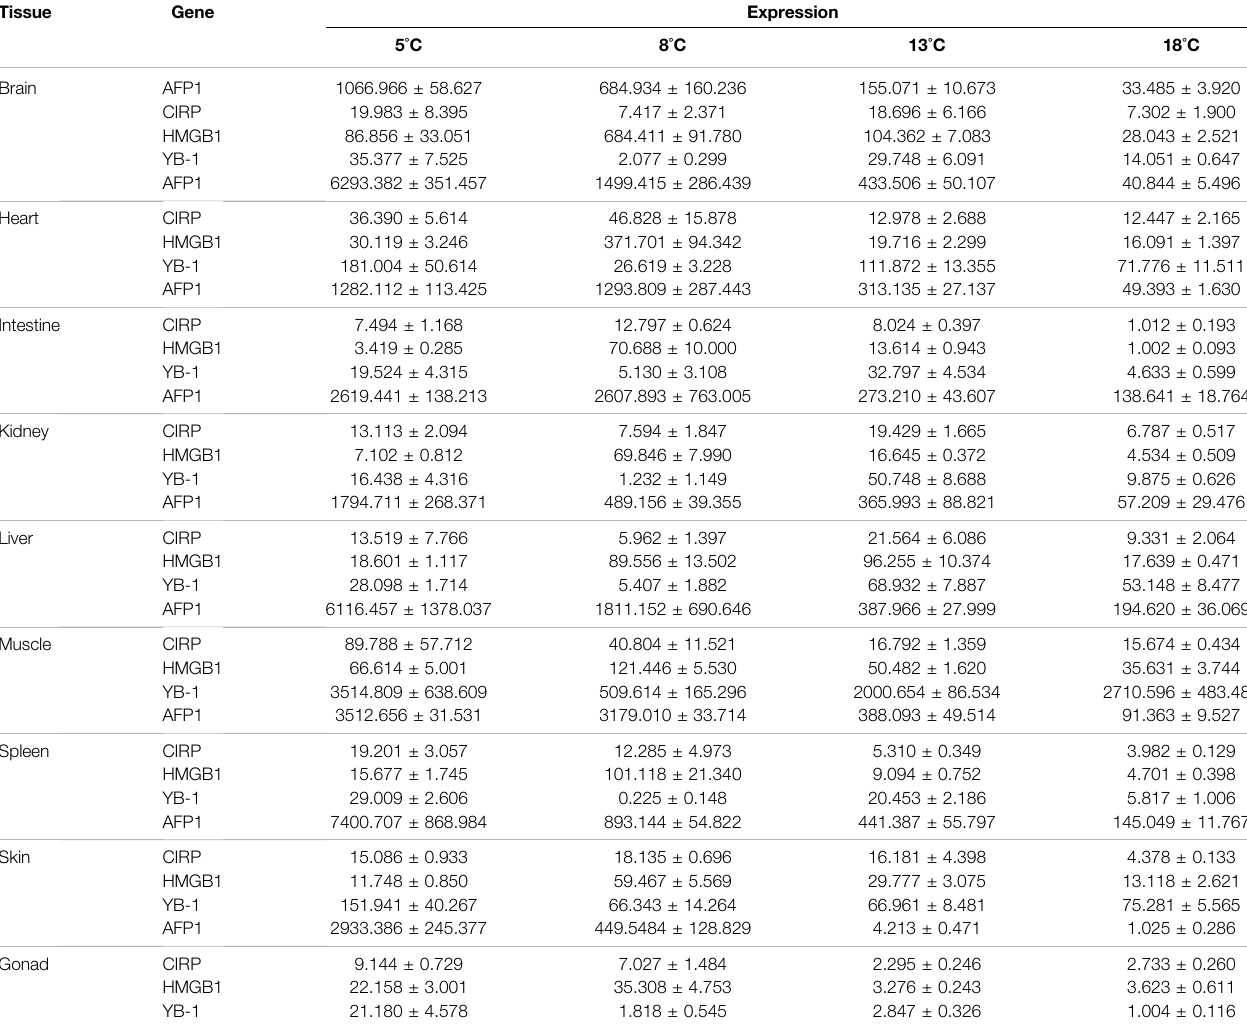
TABLE 2 | Expression of AFP1, CIRP, YB-1, and HMGB1 in different tissues from fi sh cultured at different temperatures (means ± standard deviations). Tissue